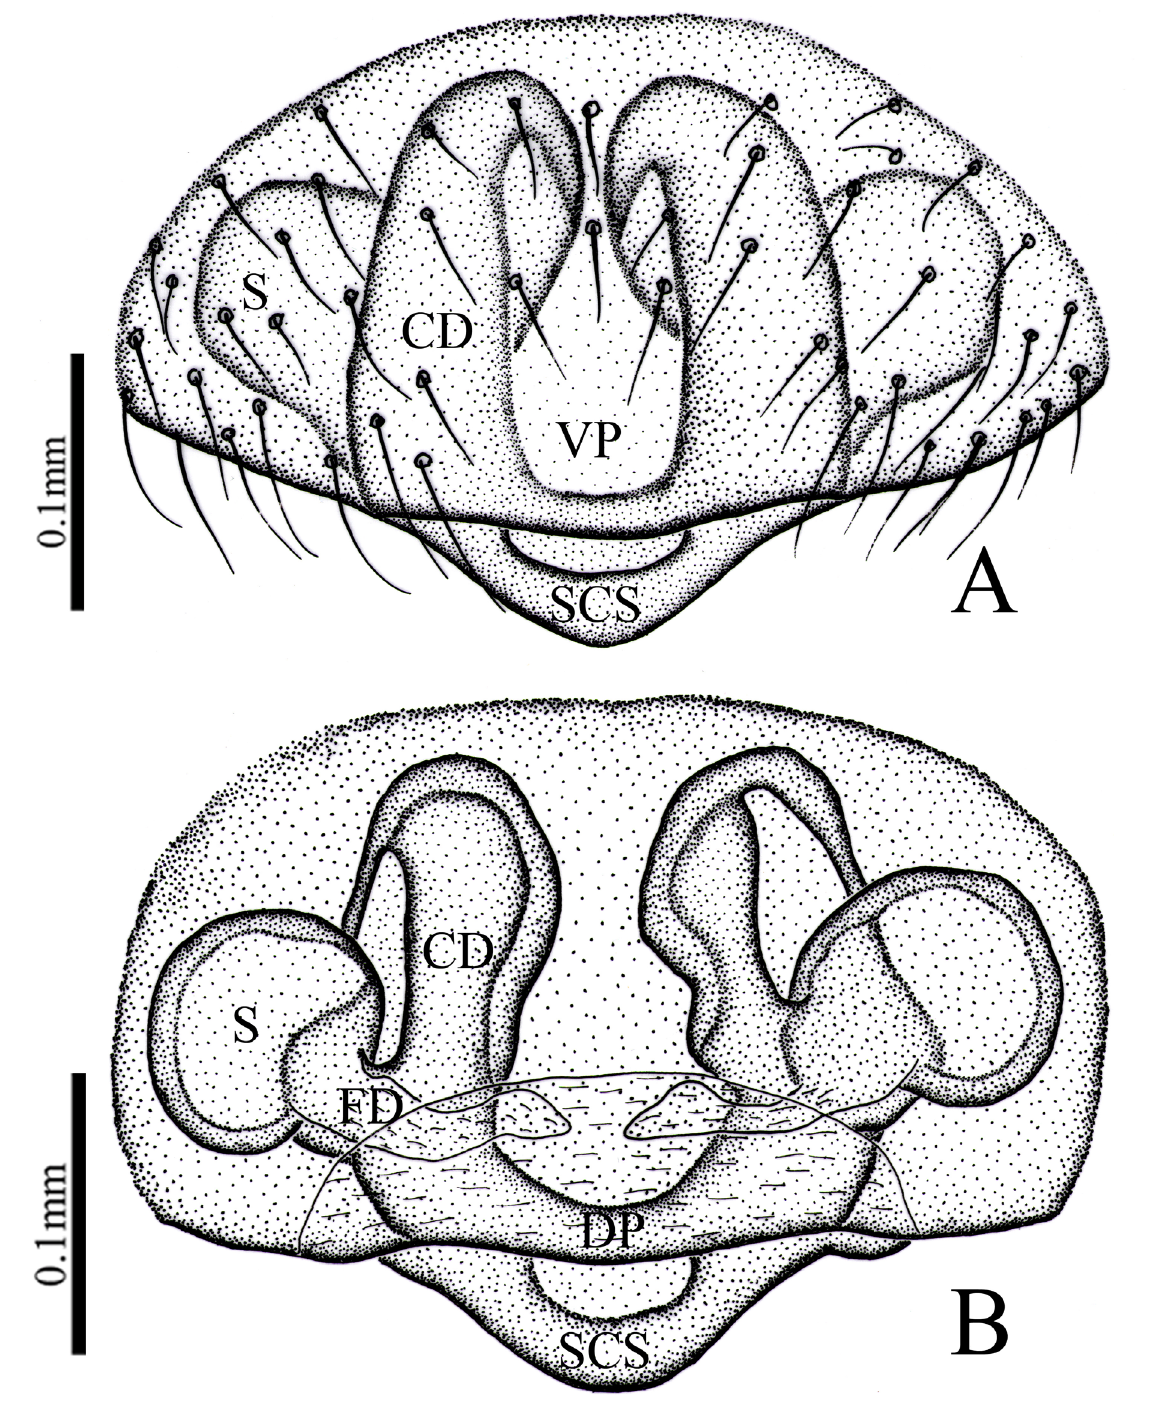
Fig. 9. Yuelushannus barbatus sp. nov., female, allotype (HNU-YLS-17-0301~02). A . Epigyne, ventral view. B . Vulva, dorsal view. Scale bars: 0.1